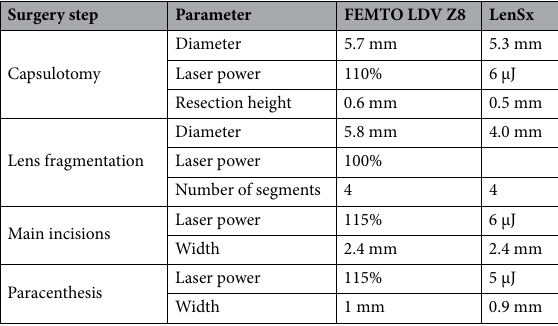
Table 1. Settings of the laser systems FEMTO LDV Z8 and